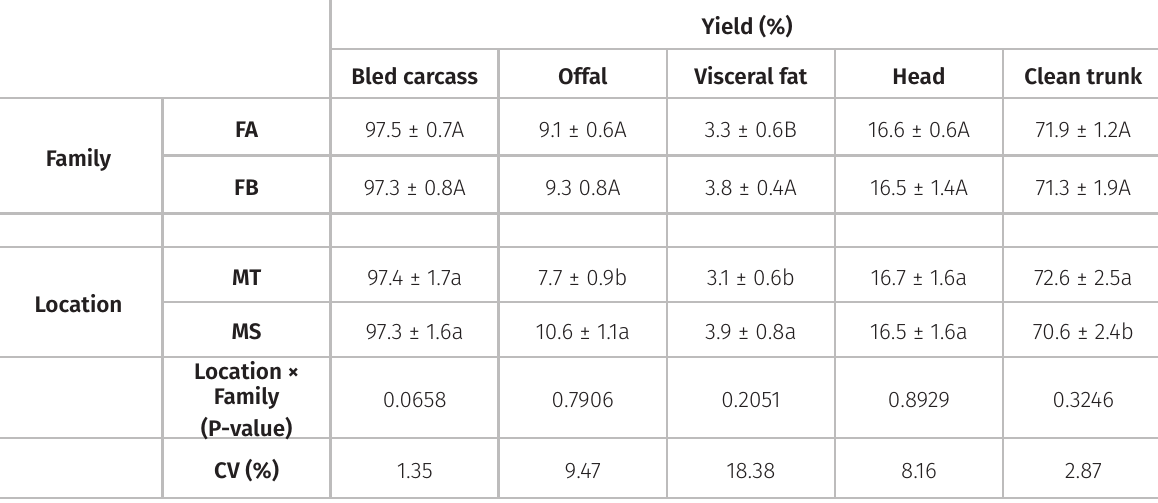
Table caption: Means followed by uppercase letters compare families regardless of location, and means followed by lowercase letters compare locations regardless of family. Common letters indicate that means do not differ statistically, according to ANOVA’s “F” test